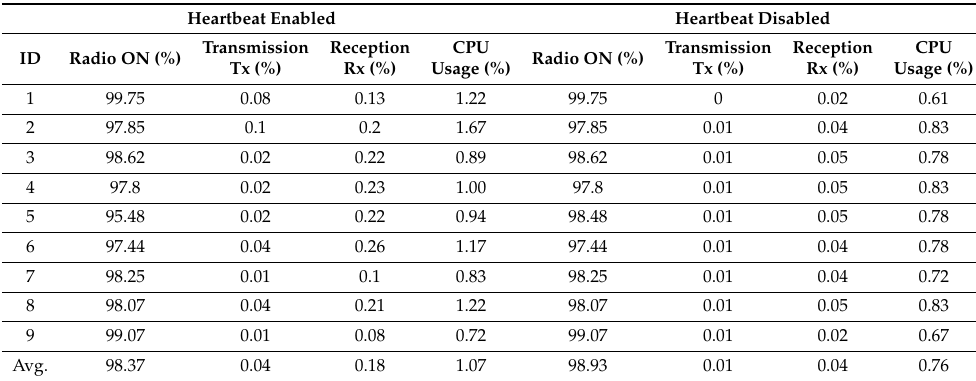
Table 3. Evaluation of the heartbeat protocol with